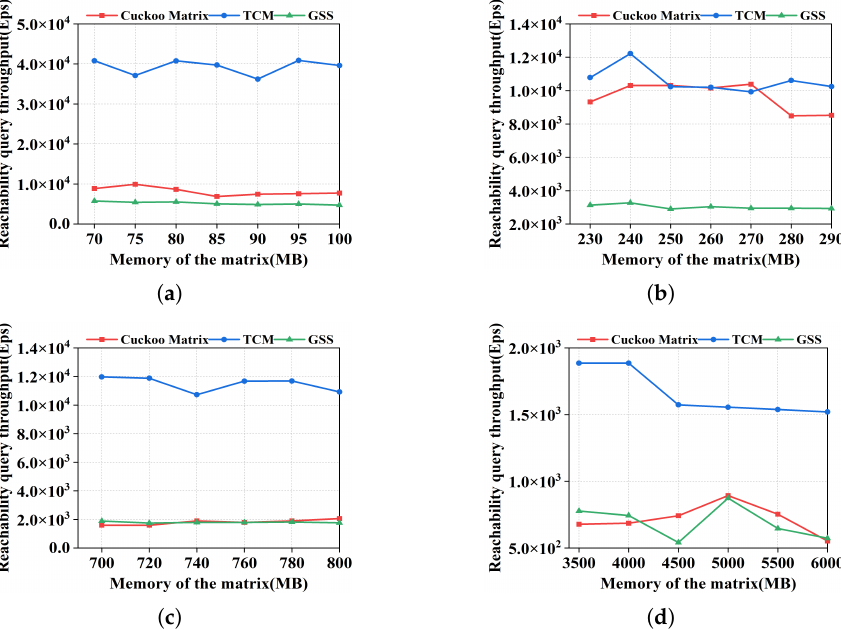
Figure 9. Throughput of reachability queries. ( a ) Skitter. ( b ) DBLP. ( c ) Orkut. ( d )